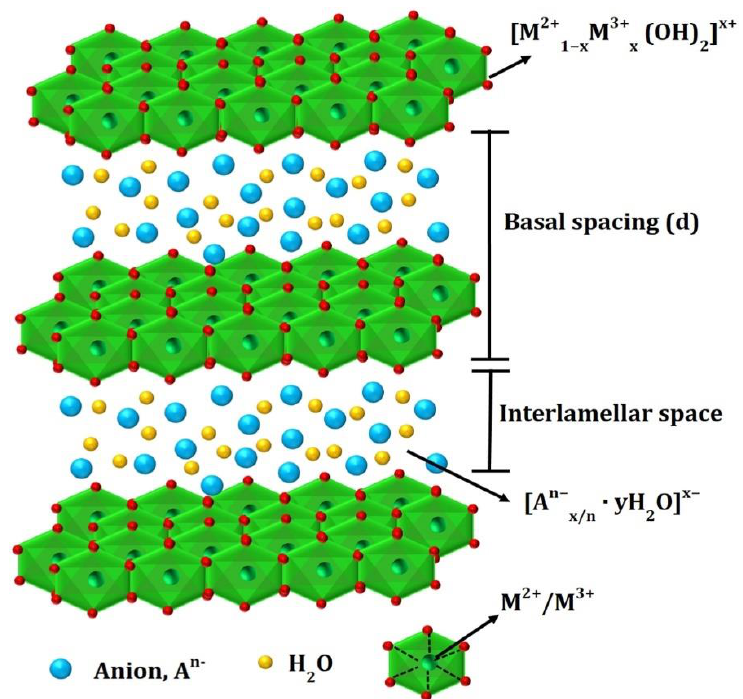
Figure 2. Typical structure of layered double hydroxide. Reproduced with permission from [40].